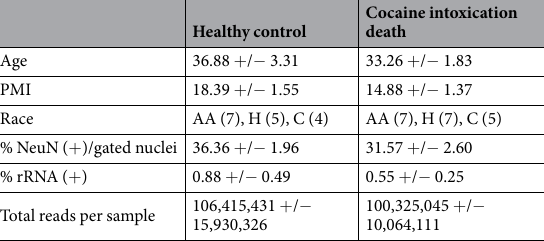
Table 1. Cohort metadata. All cases were male. Mean + / − SEM are shown. (t-test with Welch’s